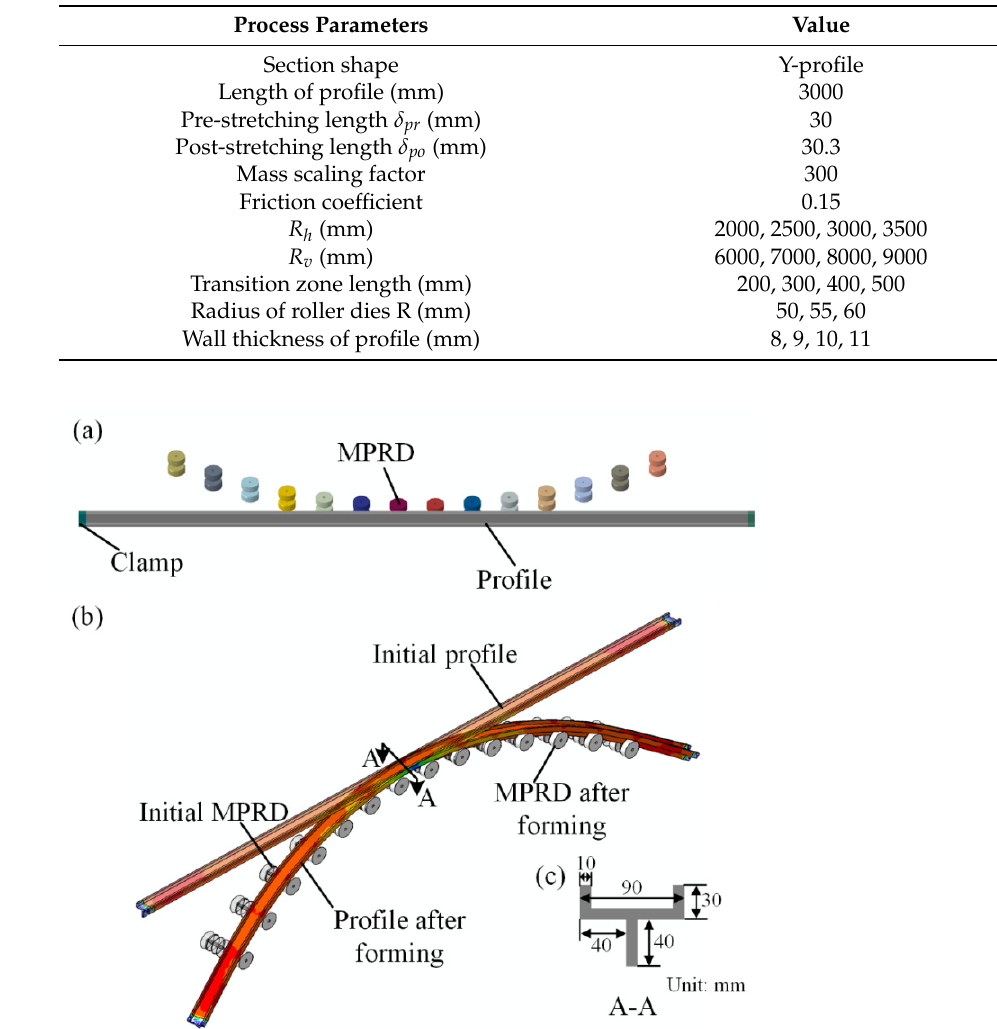
Table 2. Process parameters of numerical modeling.